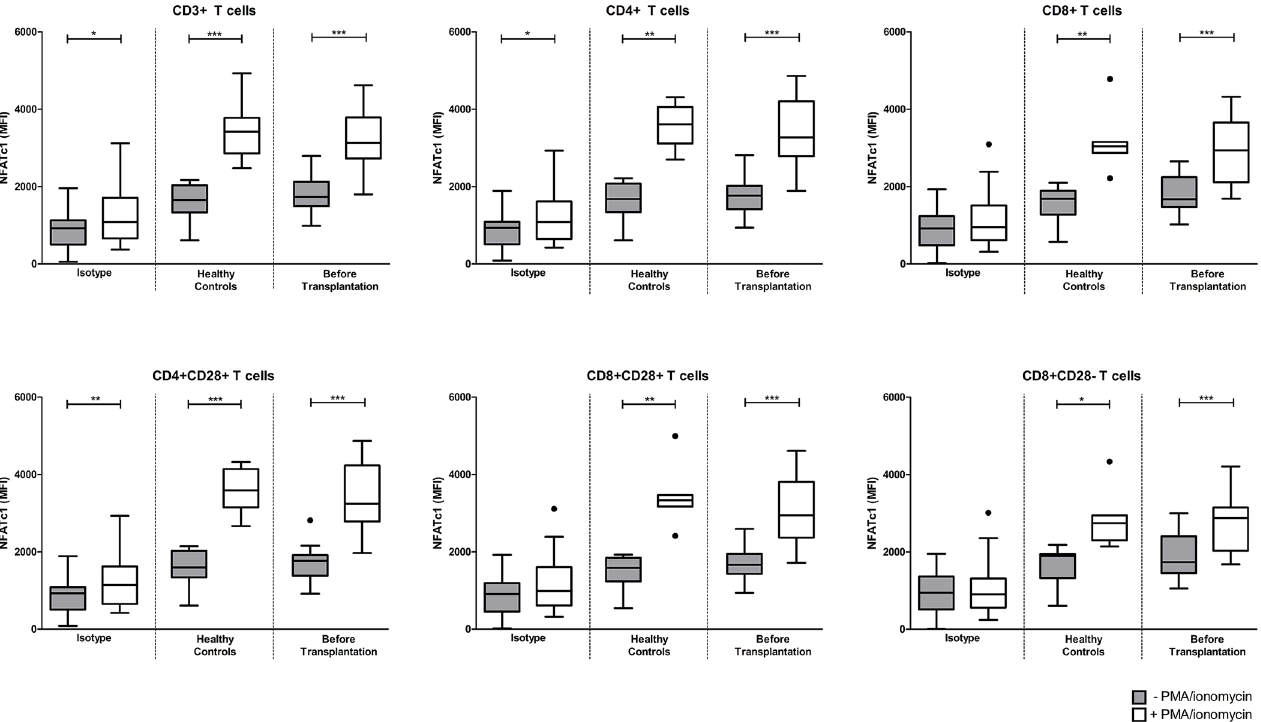
Fig 3. NFATc1 expression (MFI) in the total study population of TAC-treated patients. Unstimulated ( grey ) and PMA/ionomycin stimulated ( white ) blood samples were stained for the expression of NFATc1 in CD3 + ( upper left graph ), CD4 + ( upper middle graph ), CD8 + ( upper right graph ), CD4 + CD28 + ( lower left graph ), CD8 + CD28 + ( lower middle graph ) and CD8 + CD28 - ( lower right graph ) T cells. Data are plotted as box and whiskers (Tukey style); n = 23 isotype controls, n = 10 healthy controls, n = 11 TAC patients before transplantation; (cid:3) ) p < 0.05, (cid:3)(cid:3) ) p < 0.01, (cid:3)(cid:3)(cid:3) ) p < 0.001.